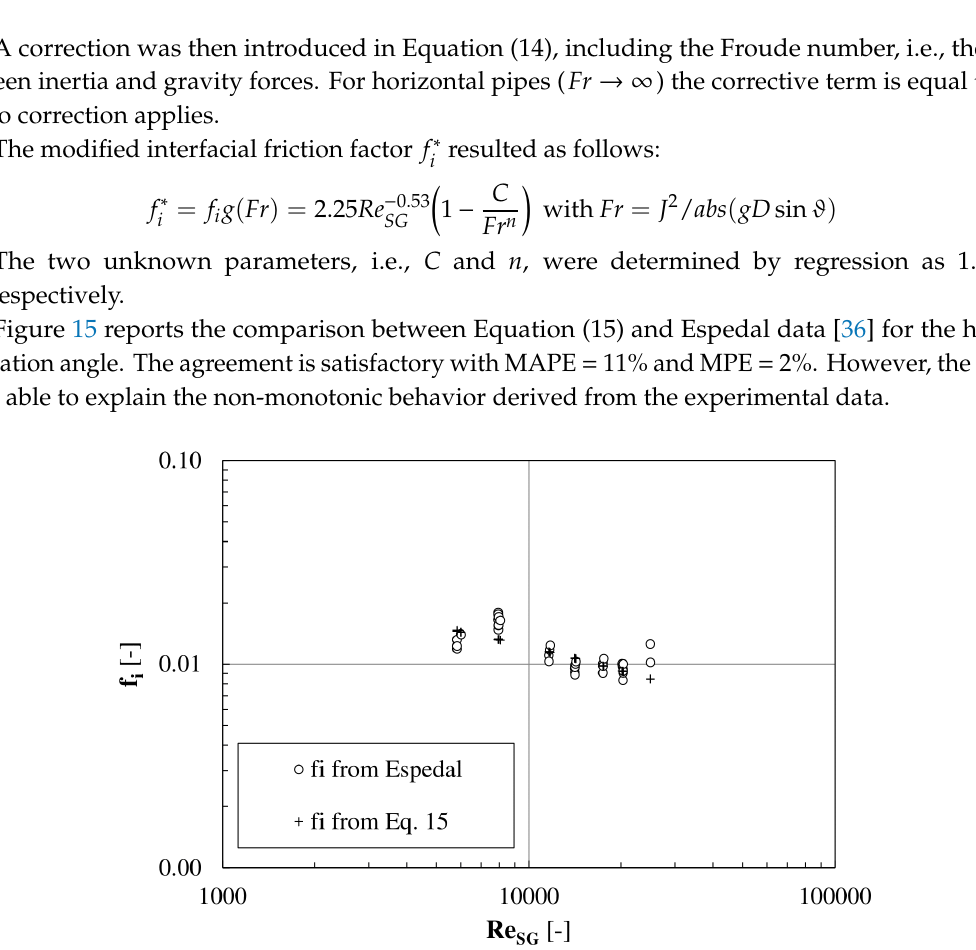
Figure 15. Interfacial friction factor vs. superficial gas Reynolds number for Espedal dataset at ϑ = – 0.5°.